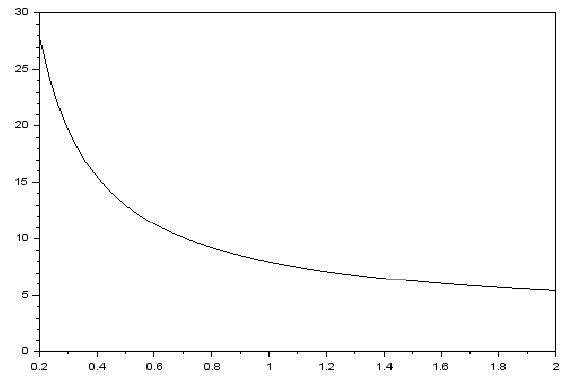
Figure 1. The shape of c a (T) as given by (19) if C D  2(C I + C R